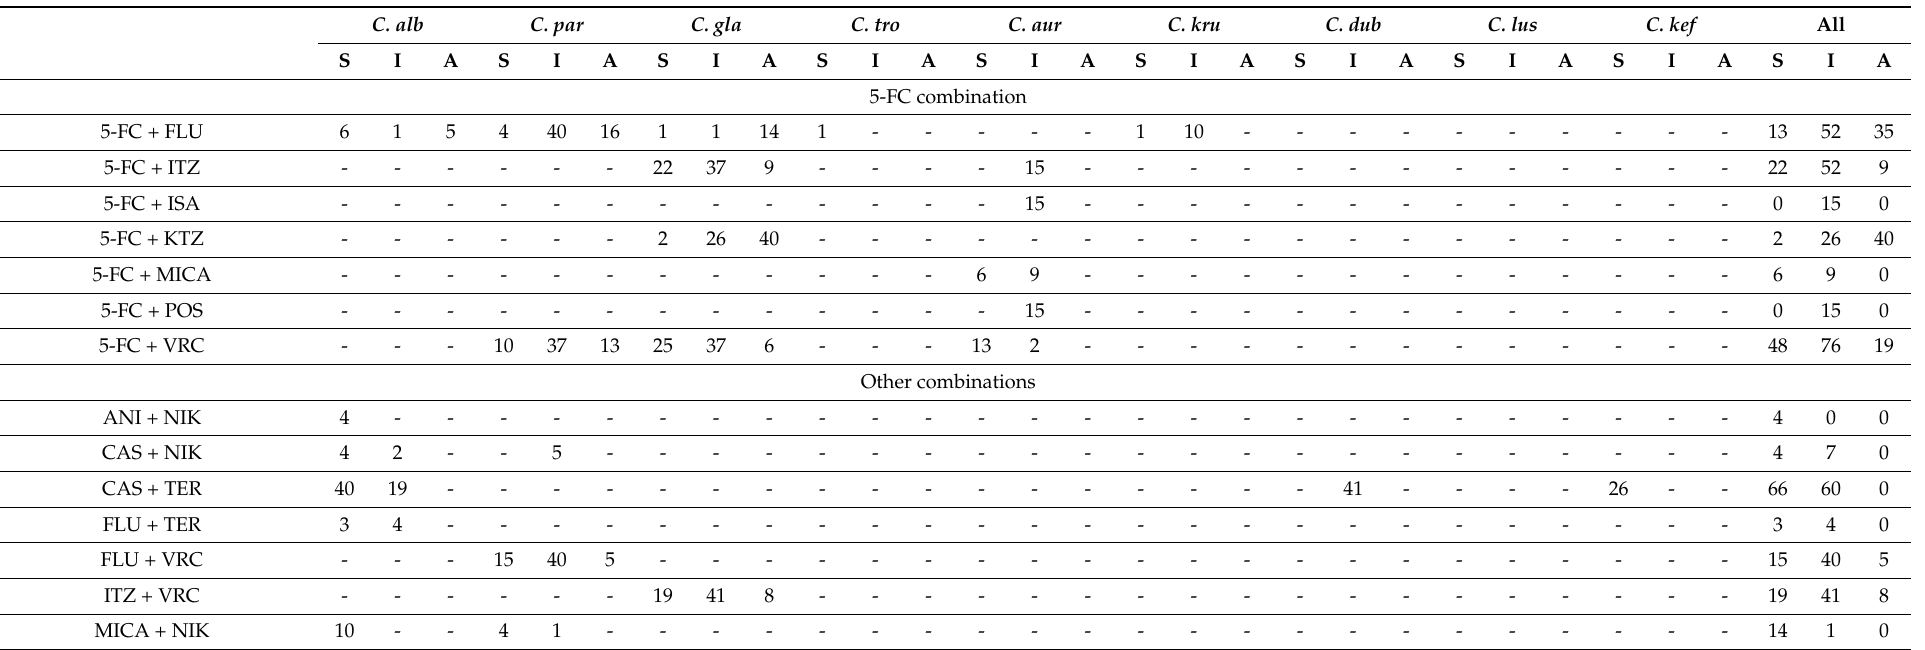
The table included results regardless the methods used to assess the interaction between antifungals. Reports with specific endpoints or using more than two antifungals in combinations were not included. Interactions for checkerboards were defined as synergistic (S) if the FIC index (FICI) was ≤ 0.5, indifferent (I) if 0.5 ≤ FICI ≤ 4.0, and antagonistic (A) if FICI was